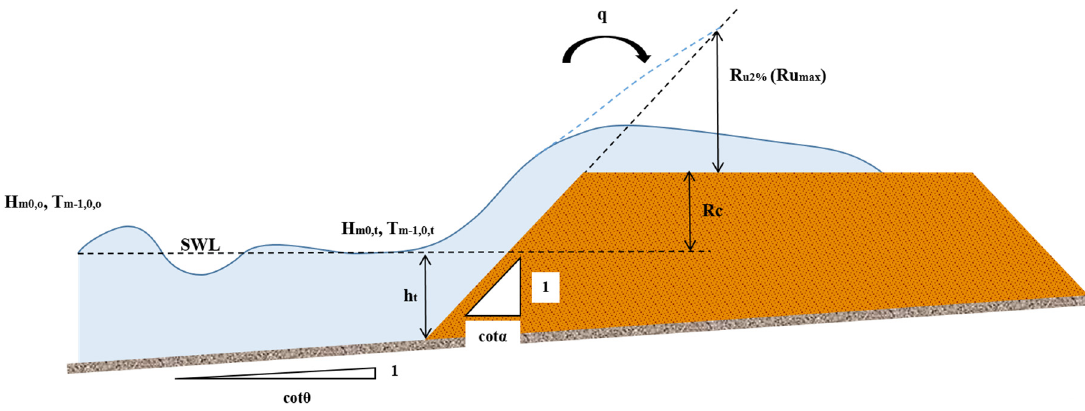
Figure 1. Sketch of wave overtopping on smooth sea dike.